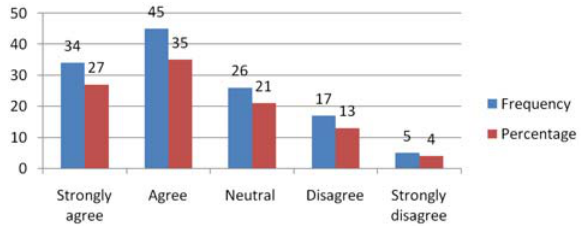
Fig. 2. Domestic demand and growth of the business